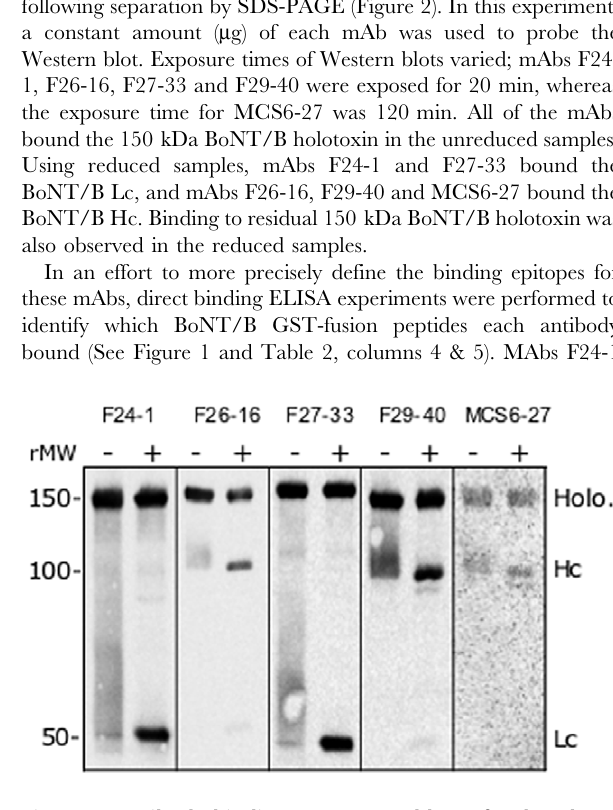
Figure 2. Antibody binding on Western blots of reduced and nonreduced BoNT/B. BoNT/B was separated on 10% SDS-PAGE in the presence ( + ) and absence ( 2 ) of 10 mM DTT, transferred to nitrocellulose membranes and probed with mAbs F24-1, F26-16, F27- 33, F29-40 and MCS6-27. Bands showing the intact holotoxin (Holo.), heavy chain (Hc) and light chain (Lc) are indicated. Protein relative molecular weight (rMW) is indicated in kDa.